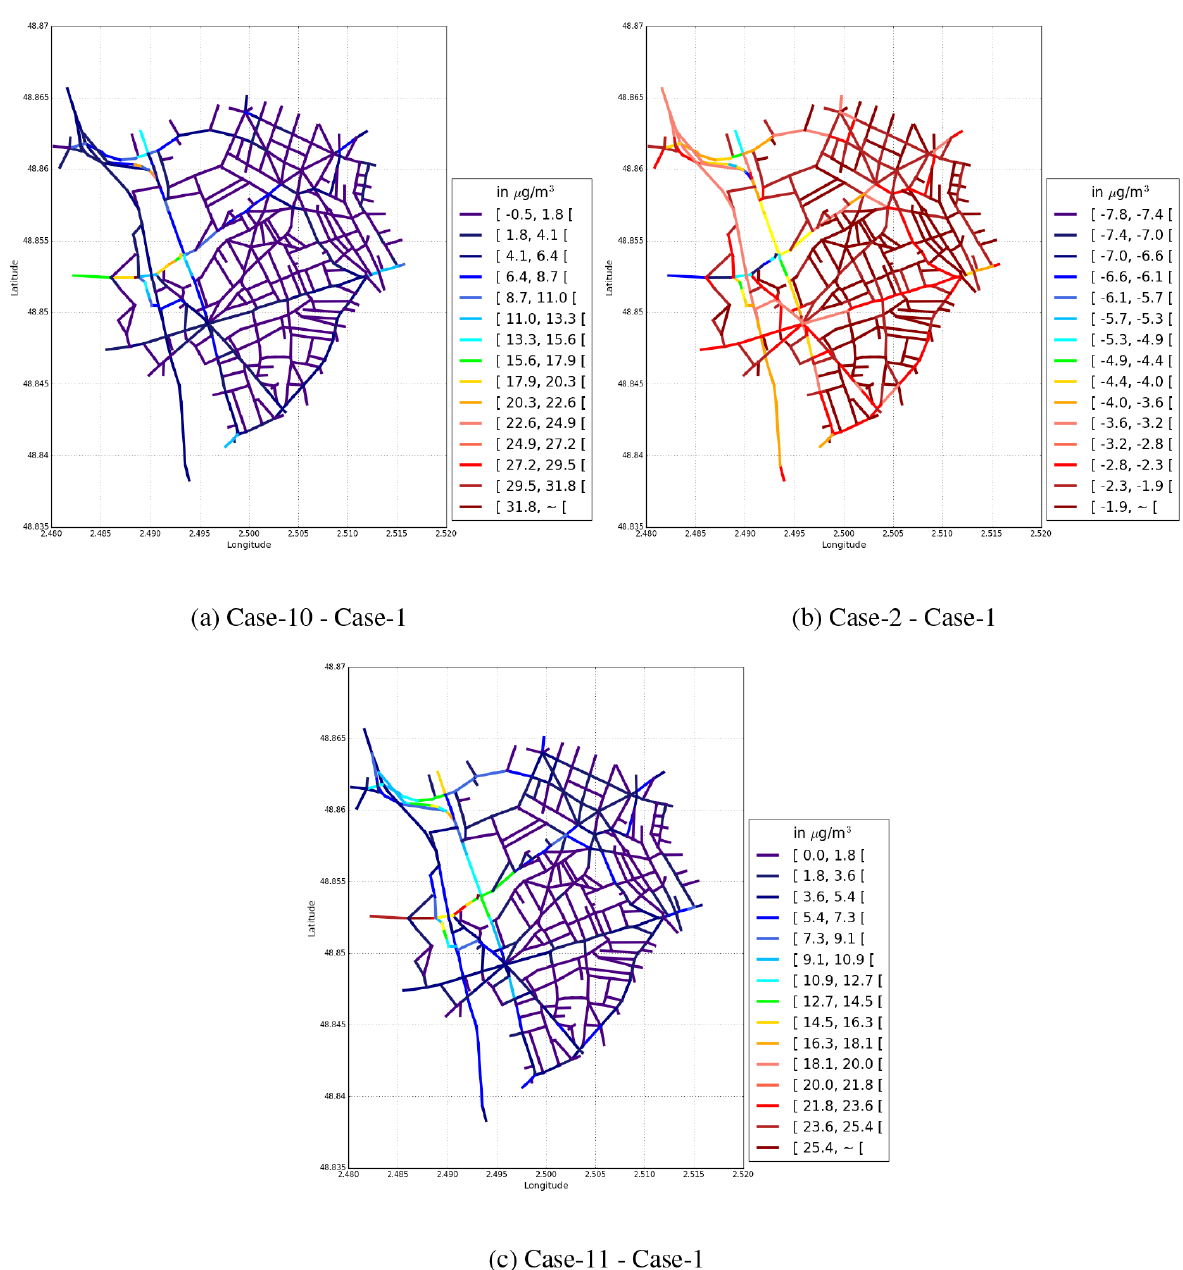
Figure C1. Differences in time-averaged PM 2 . 5 concentrations (in µgm − 3 ) between the reference test case (Case-1) and a sensitivity test